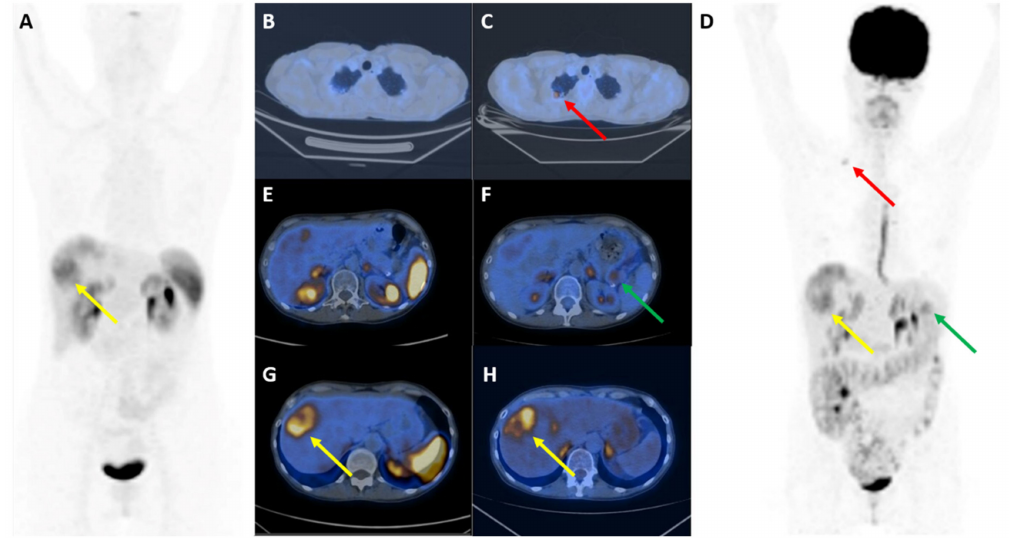
Figure 2. [ 68 Ga]Ga-DOTANOC ( A , B , E , G ) and [ 18 F]FDG ( C , D , F , H ) images in a G2 panNET patient studied for staging. Discordant pattern of uptake can be documented at lung level (transaxial fused images and MIP ( B – D ): red arrows shows FDG-only positivity), at pancreatic primary level (transaxial fused images ( E , F ): green arrows show FDG-only positivity), and liver level ( A , D , G , H : yellow arrows show di ff erent distribution of both tracers within the same